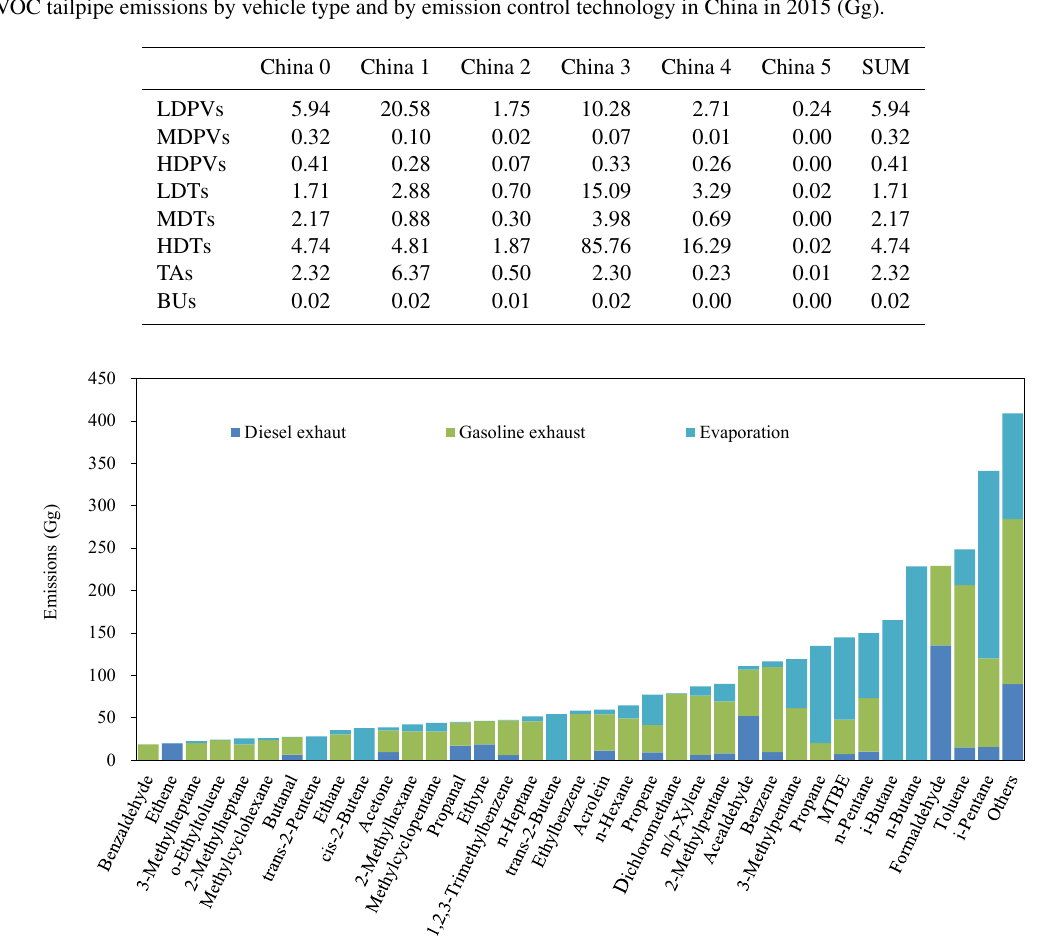
Figure 6. Speciated VOC component emissions classified by emission